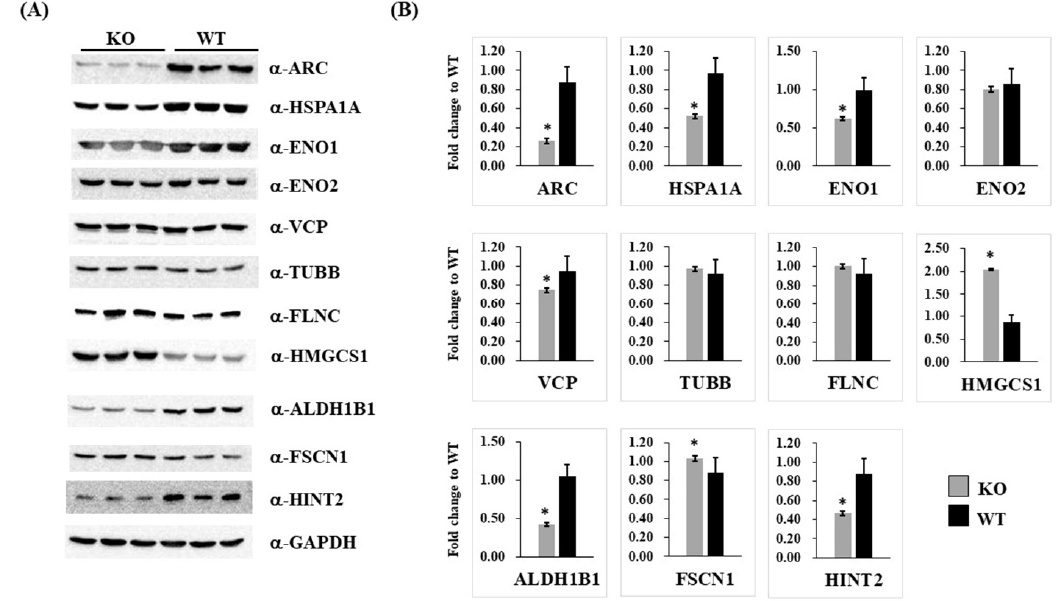
Figure 4. Immunoblotting analysis for validation of the differential expression of 11 proteins in ARC ‐ KO cells. Immunoblotting ( A ) and quantification of protein expression ( B ) confirmed the differential expression of 11 proteins (ARC, HSPA1A, ENO1, ENO2, VCP, TUBB, FLNC, HMGCS1, ALDH1B1, FSCN1, and HINT2) in ARC ‐ KO and ARC ‐ WT HEK293 cells. GAPDH was used as the loading control. Data are expressed as fold changes relative to ARC ‐ WT ± SD (* p < 0.05; n = 3).